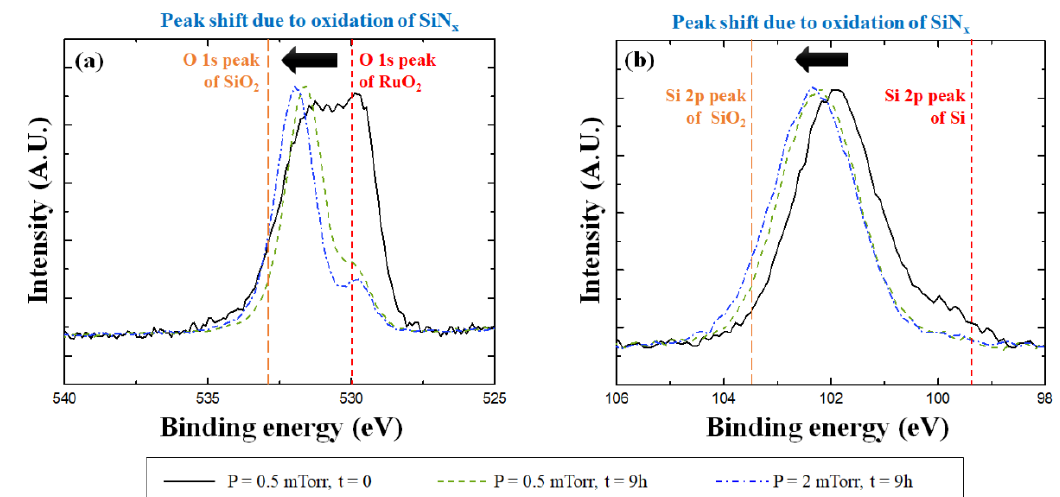
Figure 4. ( a ) O 1s and ( b ) Si 2p XPS spectra depending on working pressure before and after laser-pulsed heating with a peak temperature of 450 °C for 9 h.